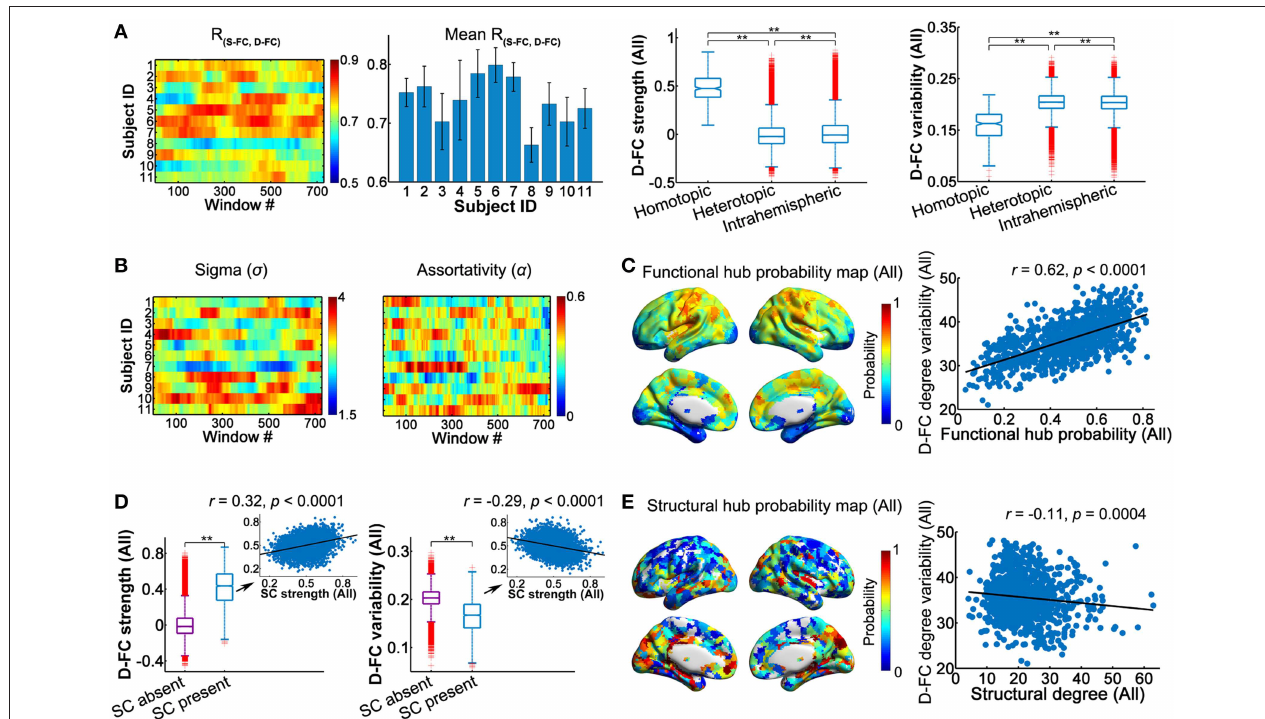
FIGURE 6 | Dynamic characteristics of high-resolution (H-1024) D-FC brain networks and their structural associations. (A) Spatial similarity between the S-FC and the D-FC matrices over time (left) and the spatial-dependence of D-FC strength and variability for all participants (right). **Bonferroni corrected p < 0 . 001 , 10,000 permutations. (B) Time-varying small-worldness and assortativity of D-FC networks. (C) Functional hub probability map for all participants (left) and scatter plot showing across-node relationship between functional hub probability and the temporal variability of functional degree centrality in the D-FC networks (right). (D) Differences in D-FC strength (left) and temporal variability (right) between region pairs with or without direct SC. ** p < 0 . 0001 . Scatter plots (insets) represent the across-connection relationship of D-FC strength (left) and D-FC variability (right) vs. SC strength, confined to the regional pairs with direct SC. Relevant statistical analyses were performed for all participants based on the SC backbone network. (E) Structural hub probability map for all participants (left) and across-node relationship with the temporal variability of functional degree centrality (right). The hub map was generated by counting the occurrence probability as structural hubs across participants for each region. SC, structural connectivity; S-FC, static functional connectivity; D-FC, dynamic functional